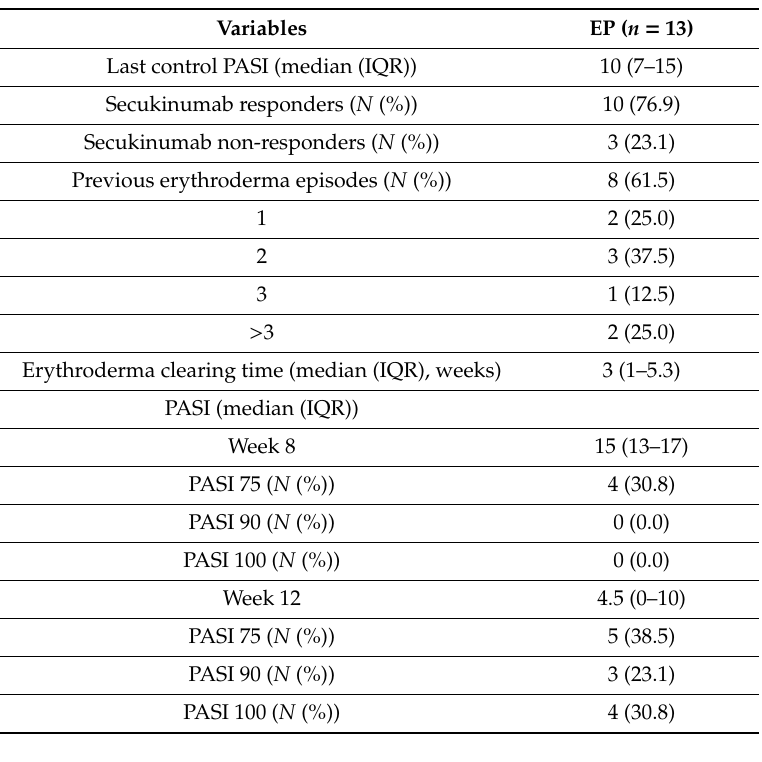
Table 3. Clinical and therapeutic records in our